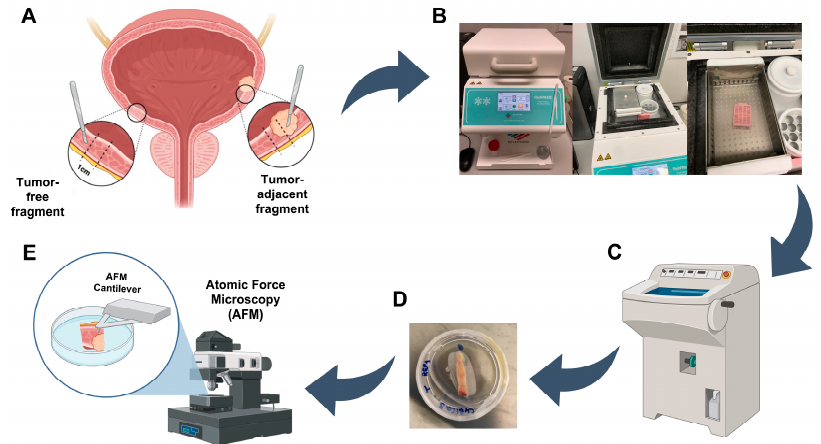
Figure 1. Tissue samples preparation for atomic force microscopy analysis. ( A ) Bladder tissue excision of tumor-adjacent and tumor-free fragments. ( B ) Tissue fragments storage at − 80 °C until AFM